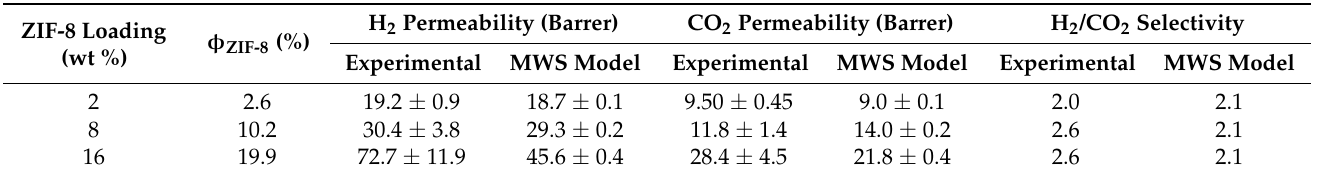
Table 2. H 2 , CO 2 permeabilities, and H 2 /CO 2 selectivity obtained with MWS model for PSf/ZIF-8 MMMs.